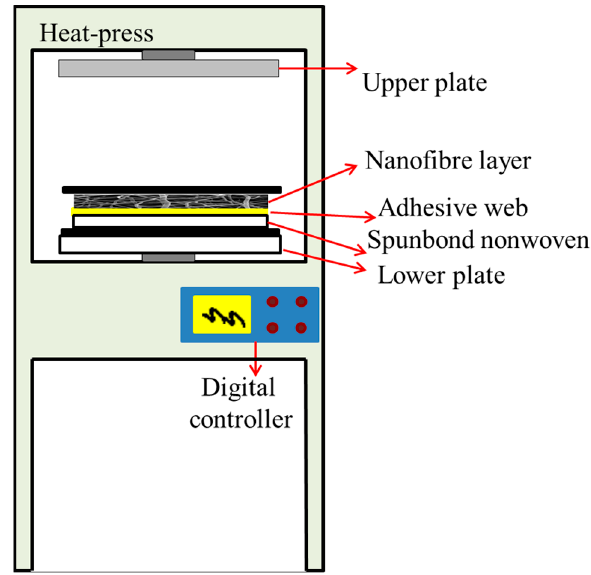
Figure 2. Schematic design of the heat-press equipment and replacement of the multilayer nanofibrous membranes.